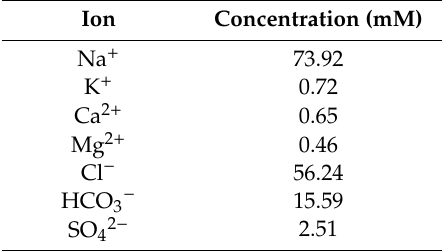
Table 1. Ionic composition of synthetic brackish water (BW)